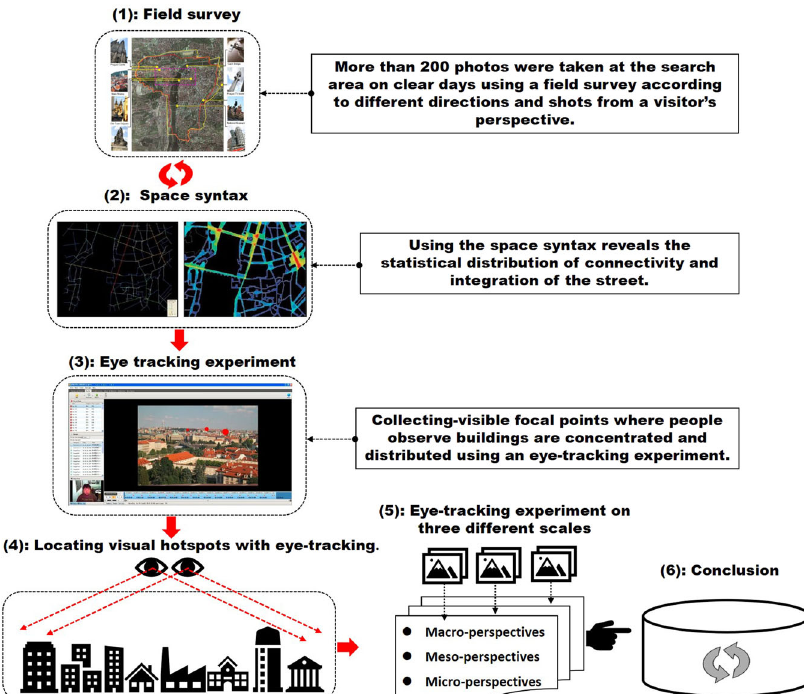
Fig. 2 Schematic illustration of the methodological path Field survey Space syntax. (1) Field survey, (2) Space Syntax, (3) Eye tracking experiment, (4) Locating visual hotspots with eye-tracking, (5) Eye tracking experiment on three different scales, (6)